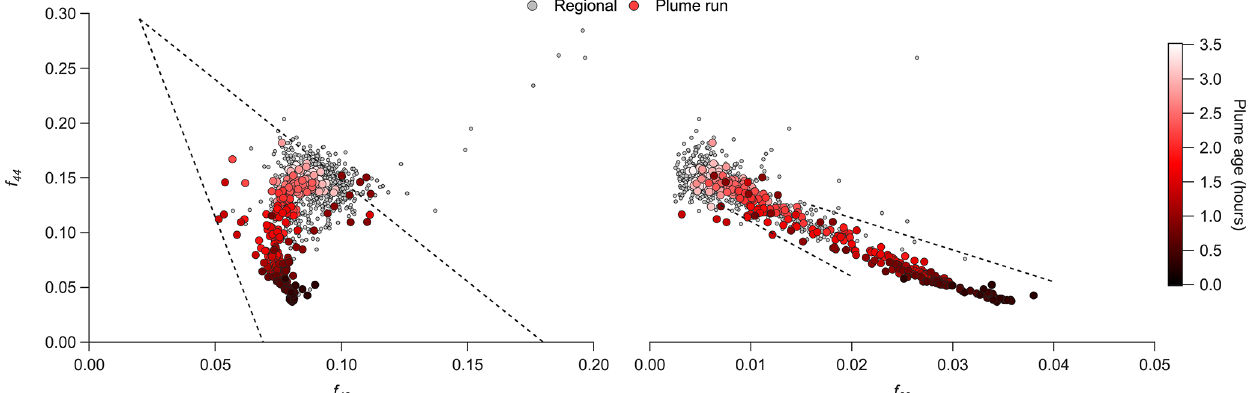
Figure 5. Comparison of f 44 vs. f 43 and f 60 during the case study analysis for B737, where f x refers to the fraction of the organic aerosol mass signal at a given mass-to-charge ratio measured by the aerosol mass spectrometer. Also shown is regional haze data during the same flight. Points from the along-plume straight-and-level run (SLR) are coloured according to the approximate plume age. Dashed lines in the f 44 vs. f 43 show the triangle space reported by prior studies focussed on organic aerosol less influenced by biomass burning (Morgan et al., 2010; Ng et al., 2010). Dashed lines in the f 44 vs. f 60 are from previous studies on biomass burning organic aerosol ageing, with the upper line from Cubison et al. (2011) and the lower line from Lack et al. (2013).